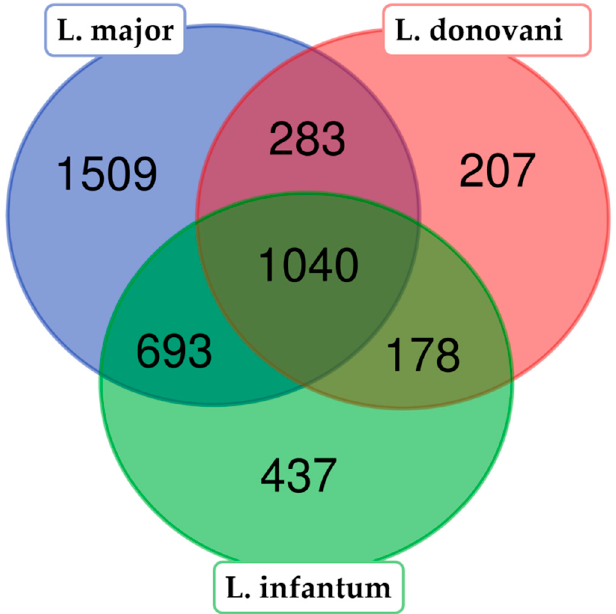
Figure 2. Comparison (Venn diagram) between the identified proteins in this work ( L. infantum, in green) and those identified in two previous studies [20,36] performing proteomic analysis in Leishmania donovani (in red) and Leishmania major (in blue). The Venn diagram was created by the tool available at bioinformatics.psb.ugent.be / webtools / . Note—the discrepancy between the number of proteins identified by Rosenzweig et al. [20] (see text) and those represented in the Venn diagram (1713 vs. 1708) was due to 5 gene duplications that were corrected after re-assembling of the L. infantum genome [13].